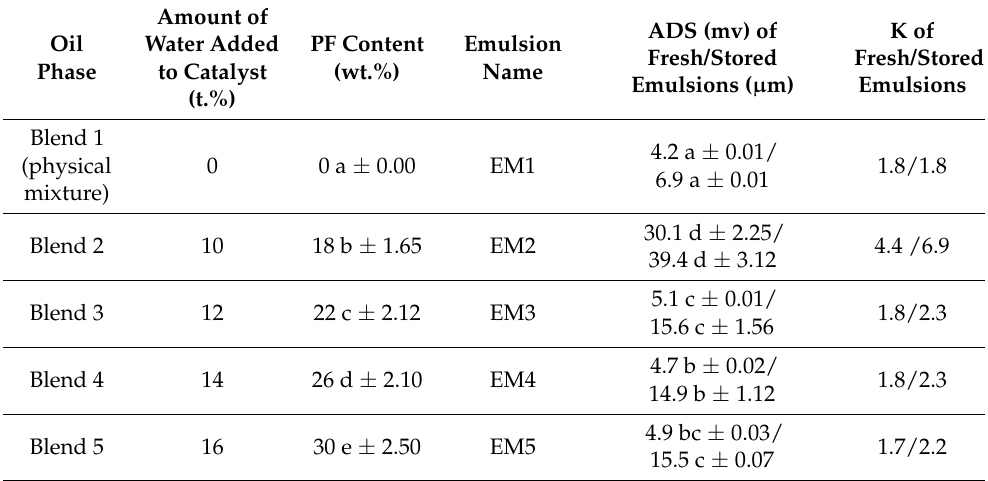
Table 1. Amount of polar fractions (PFs) in the oil phases, average droplet size (ADS), and dispersion index (K) of emulsions prepared from modified lipids, determined after 72 h and after 8 weeks of